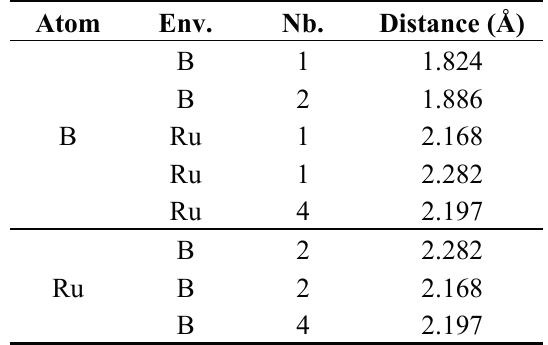
Figure 9. Environment of TM and B atoms in the oP6 (RuB 2 -type) structure. Table 8. Bond lengths in the oP6-RuB 2